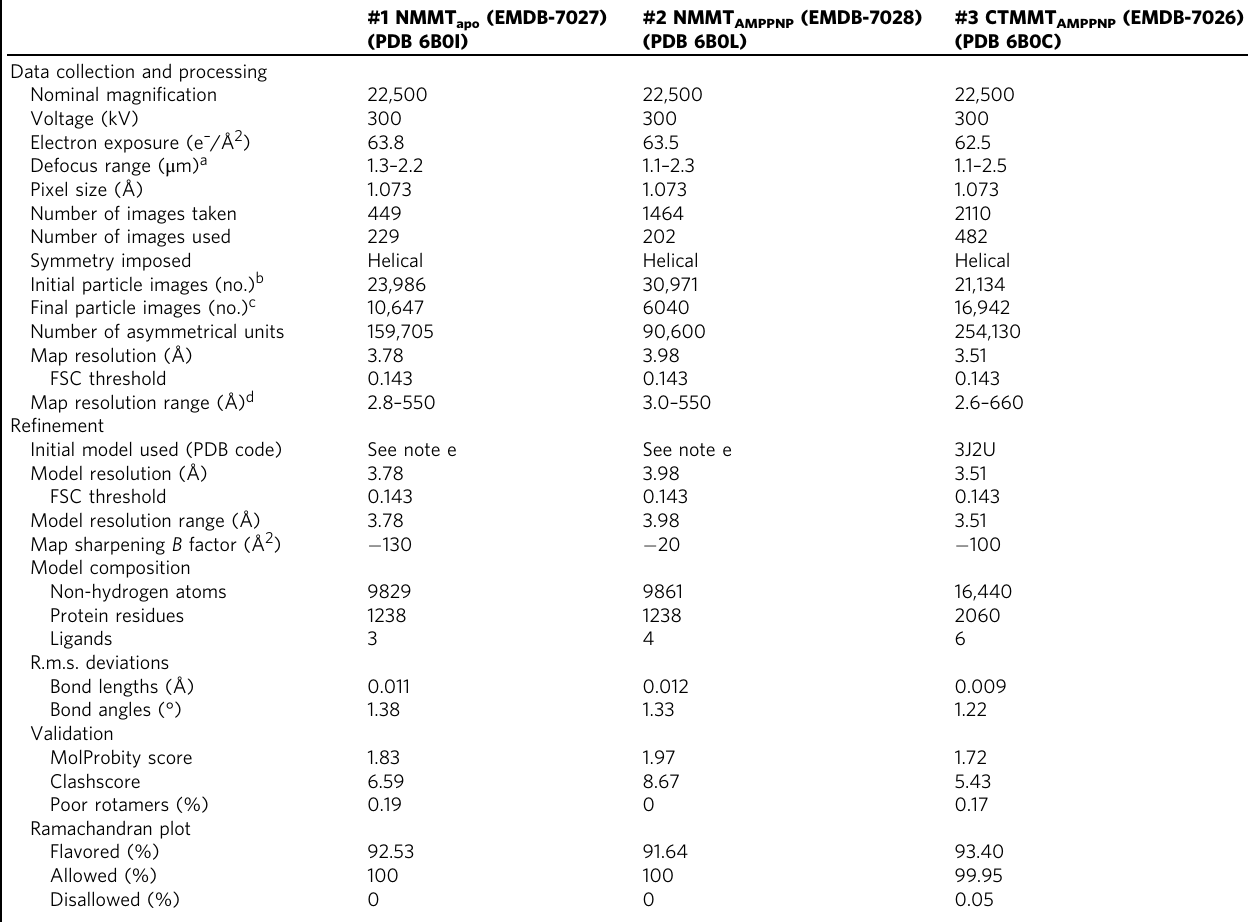
Table 1 Cryo-EM data collection, re fi nement, and validation